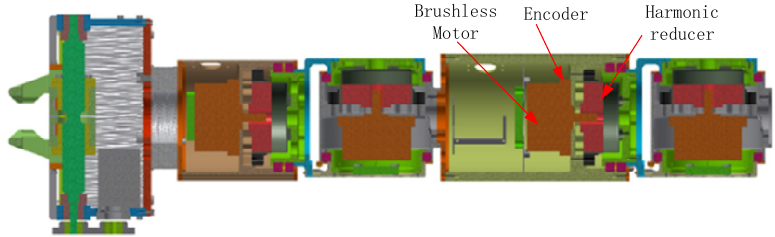
Figure 4. Bionic robot arm and end effector.